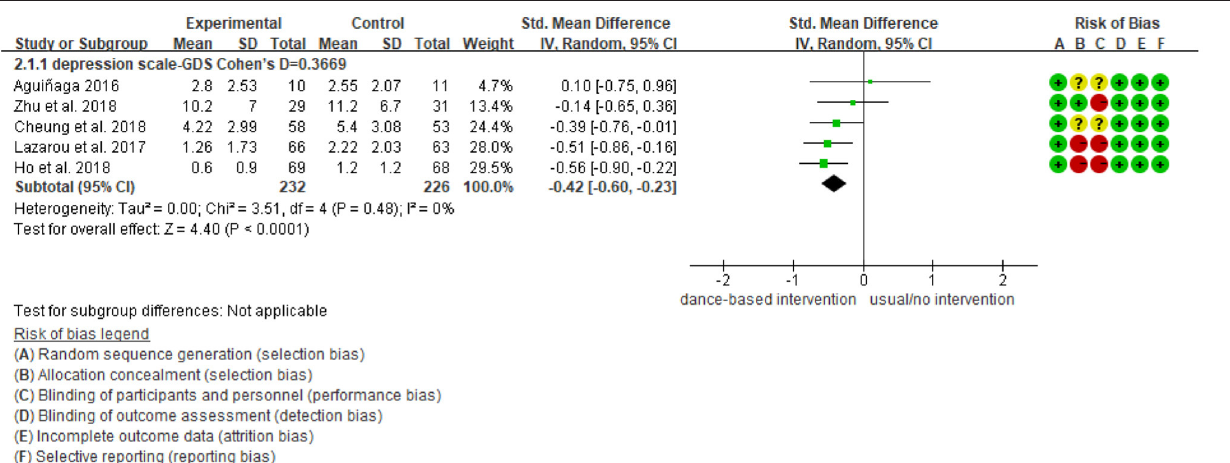
FIGURE 3 | Effect size of the intervention group vs. the control group on depression rating scores.